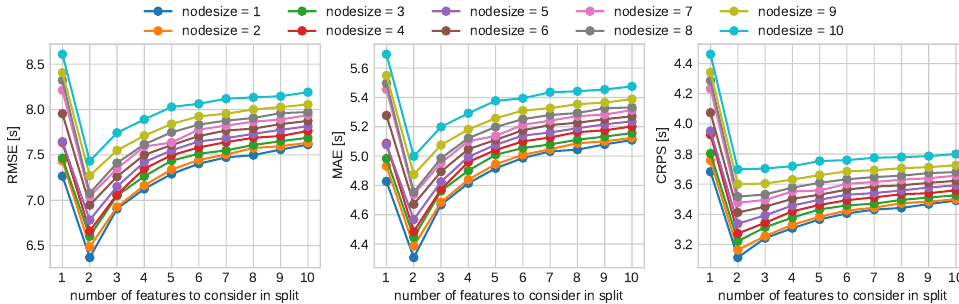
Figure 9. Results of three different accuracy measures for various model configurations consisting of a combination of parameters for the number of features to consider in a split, and for the minimum number of samples in the leave nodes (nodesize). In all three cases, the best performance is reached for the configuration with two features per split and a single data point per leave. In all cases, the number of trees per forest is 100. All calculations were conducted on the validation data set.